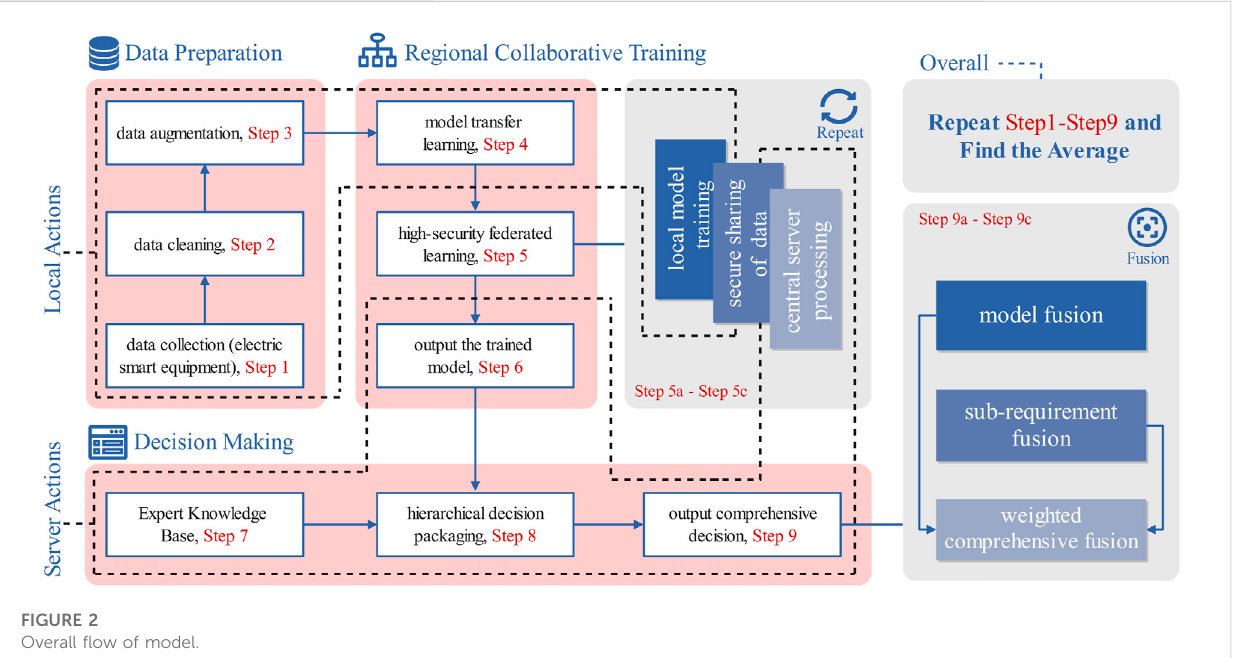
FIGURE 2 Overall fl ow of